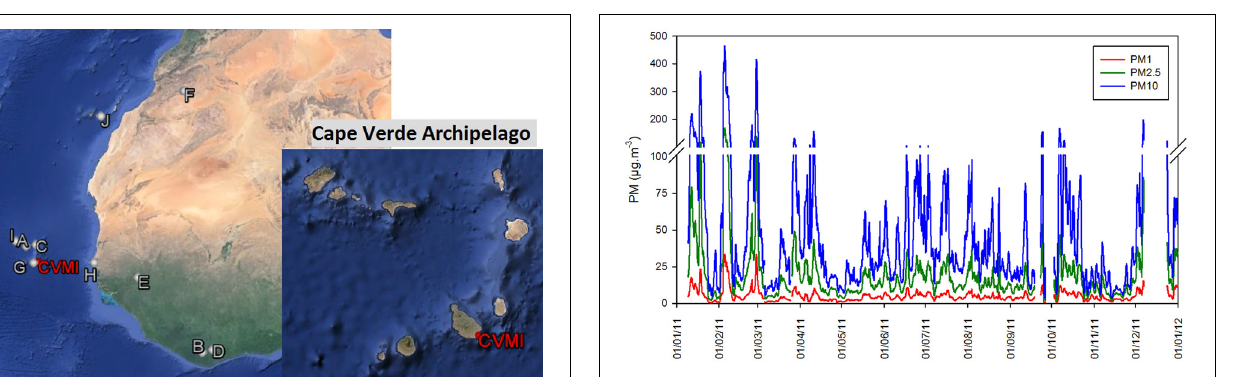
can reach values higher than 1000 μ g.m − 3 , while 24 h run average values can reach maxima of 460 μ g.m − 3 . Figure 7 represents